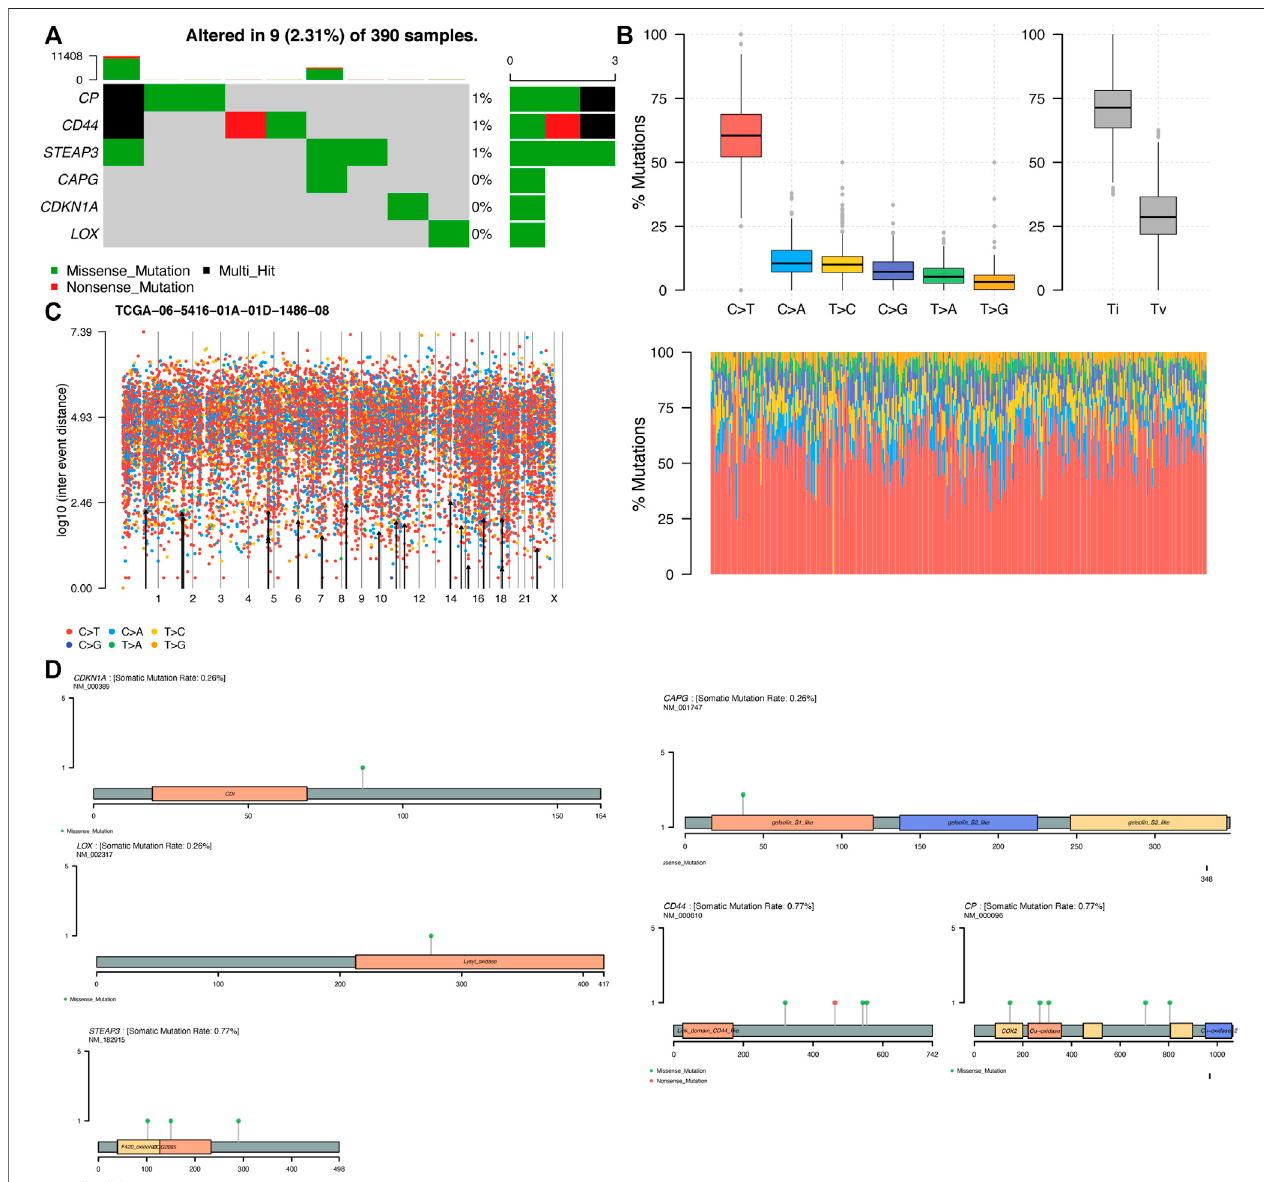
FIGURE 12 | Single-nucleotide variant (SNV) analysis (A) The key genes are sorted according to their mutation frequency, and different colors represent different mutation types (B) The transition plot shows the distribution of mutations in each sample in TCGA-GBM. The stacked bar plot (bottom) shows the mutation spectrum distribution (C) RainfallplotofthemutationdistributionspectrumofTCGA − 06 − 5416 − 01A − 01D − 1486 – 08 (D) Distributionofmutationsandproteindomainofkeygenes with high mutation frequency. The main body of the image shows the protein structure with the structure name marked in the box and the lollipop indicates the